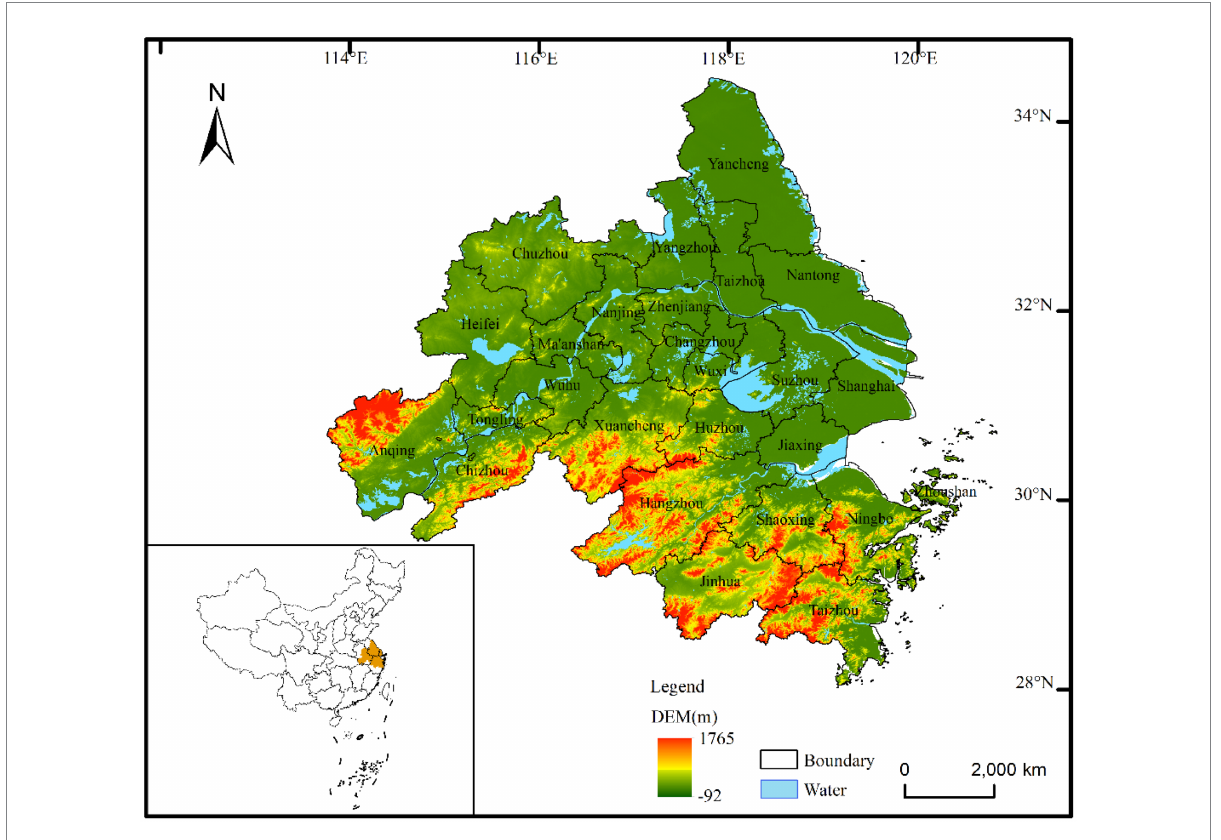
FIGURE 2 The location of the Yangtze River Delta Urban